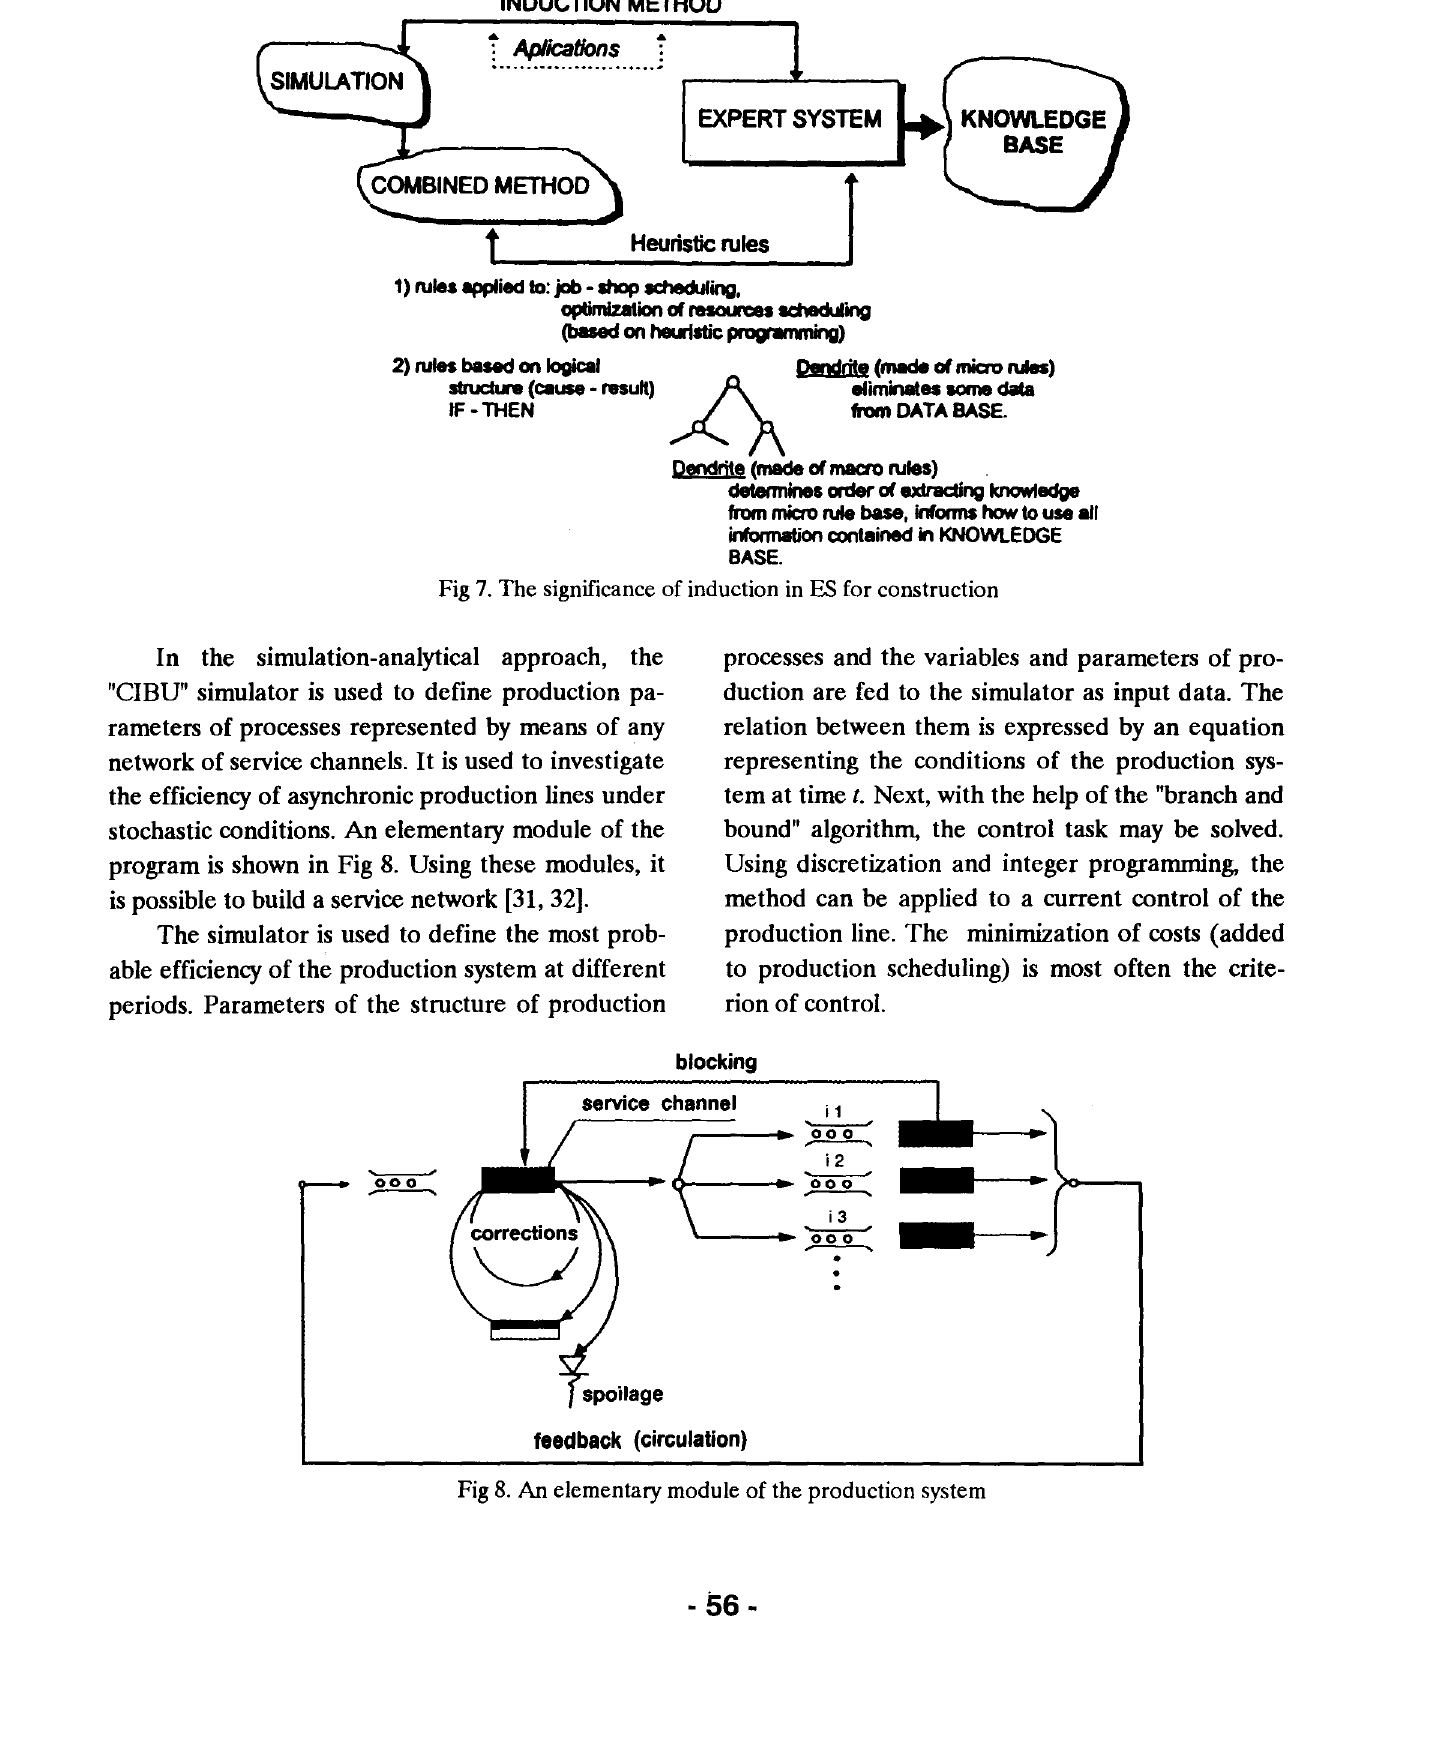
Fig 8. An elementary module of the production